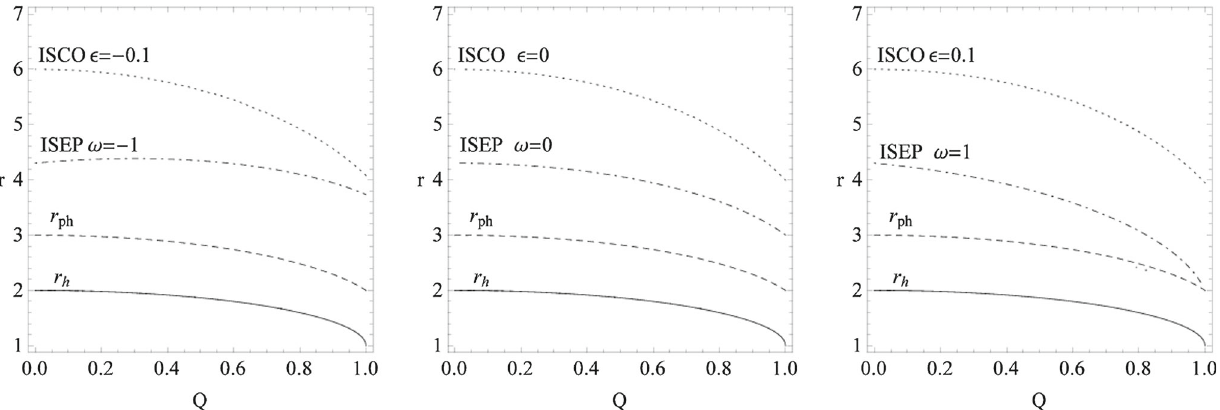
string and charged black hole. ISCO for charged particles are defined for three different charge to mass ratio (cid:21) values